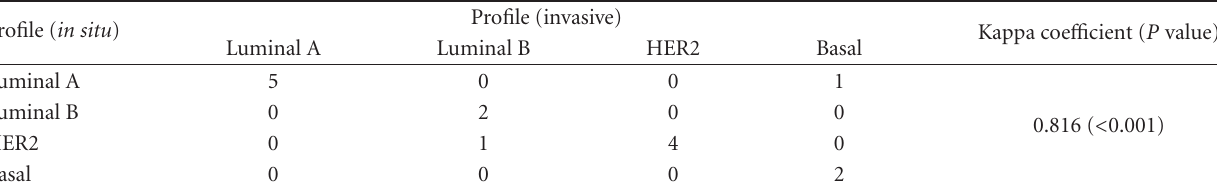
Table 7: Concordance between immunophenotypical profiles of in situ malignant epithelial component and invasive malignant epithelial component ( n =